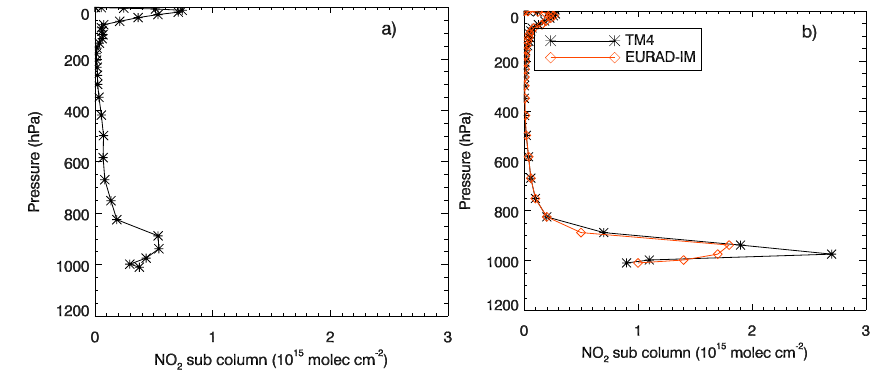
Fig. 7: A priori NO 2 profiles for (a) summer and (b) winter. Fig. 7. A priori NO 2 profiles for (a) summer and (b)